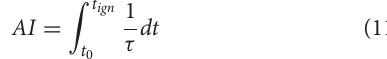
FIGURE 2 | Predicted AI crank angle (indicated by stars) as a function of PRF number for various thermal profiles, with lines showing CA5 (red dashed), CA50 (yellow dash dotted), and CA95 (blue